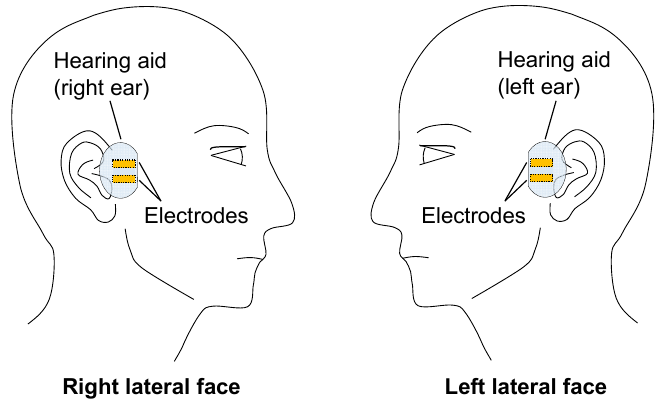
Figure 1. Human body communication (HBC) system composed of two head-mounted wearable devices (hearing aids).